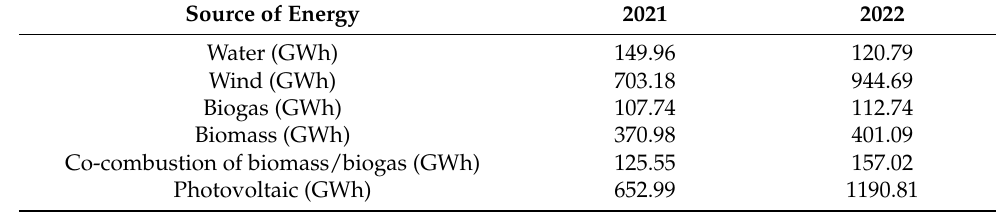
Table 4. Energy production by source in June 2022, compared to June 2021.